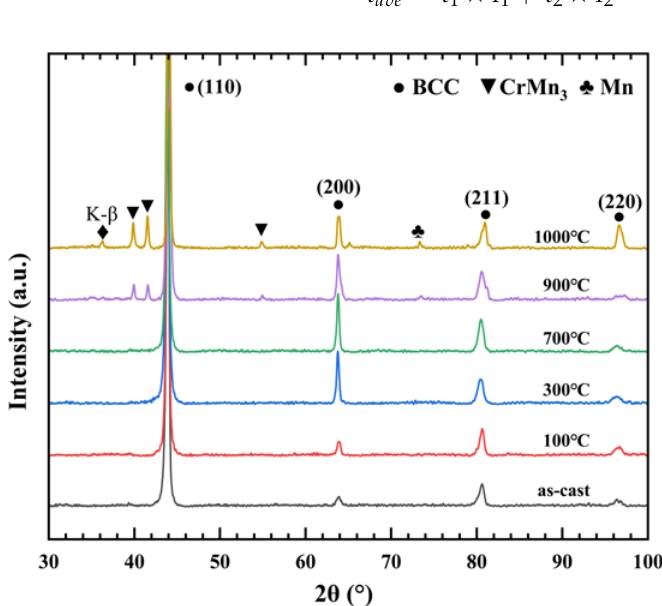
Figure 2. The XRD patterns of the V − Cr − Mn alloy at different annealing temperatures.